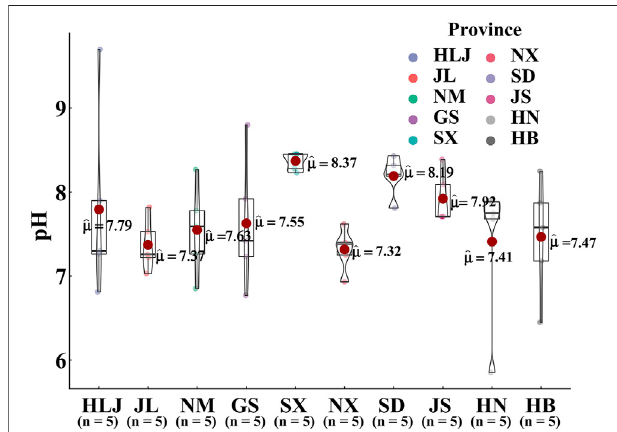
FIGURE4| ThepHoftoiletfecessurveyedin10provinces(regions).The fi gureshowsboxplots,dotplotsandviolinplotsoffecaldistributionindifferent provinces, in which û represents the mean of 5 samples and n represents the number of